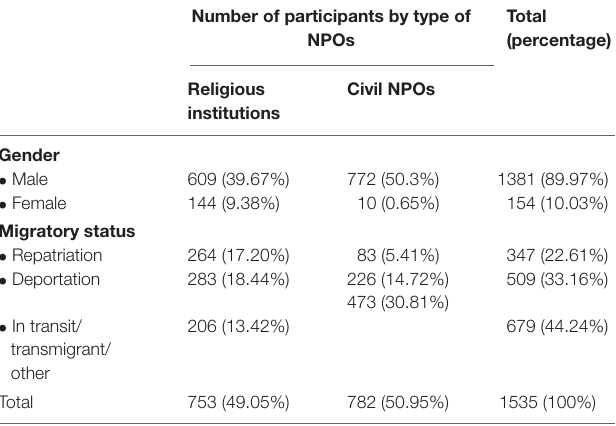
TABLE 2 | Descriptive